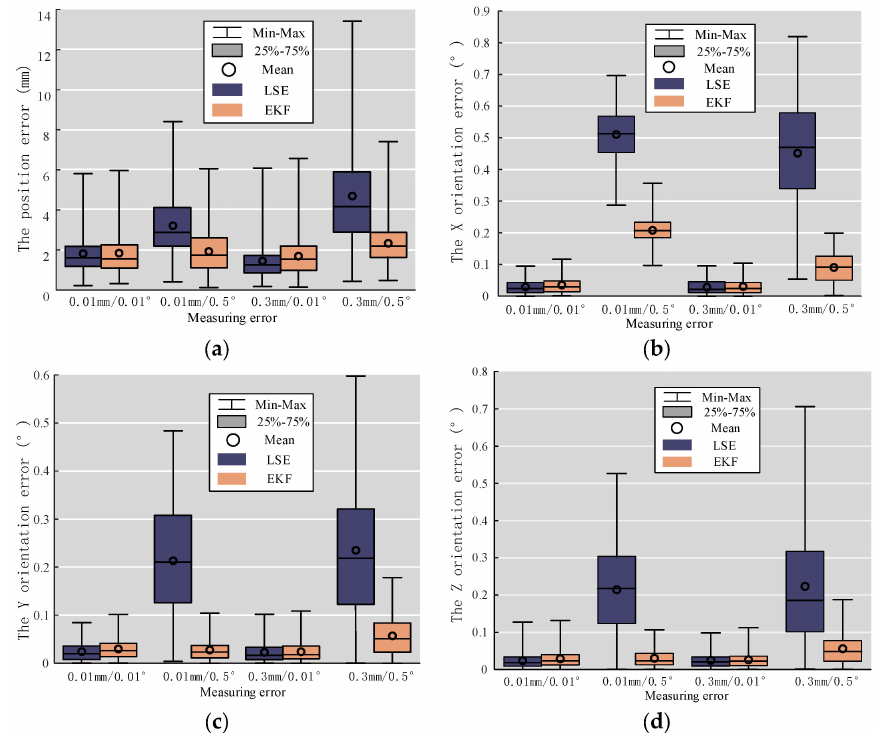
Figure 9. Calibration results with different measurement errors: ( a ) the position error; ( b ) the X orientation error; ( c ) the Y orientation error; and ( d ) the Z orientation